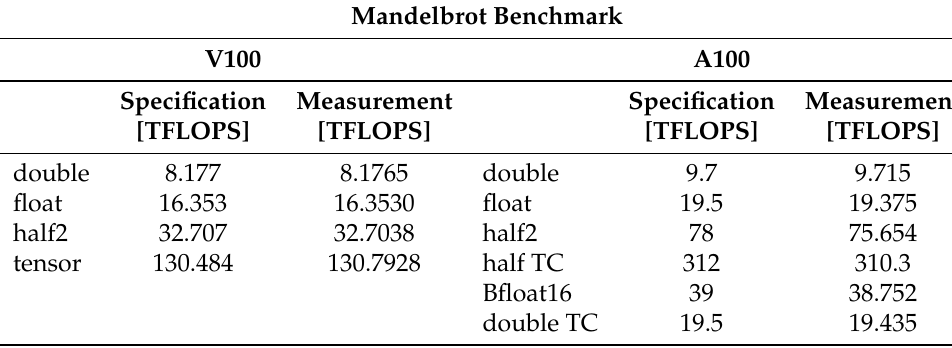
Table 2. Performance comparison V100 on the left to A100 on the right. Performance measured by Mandelbrot benchmark compared to